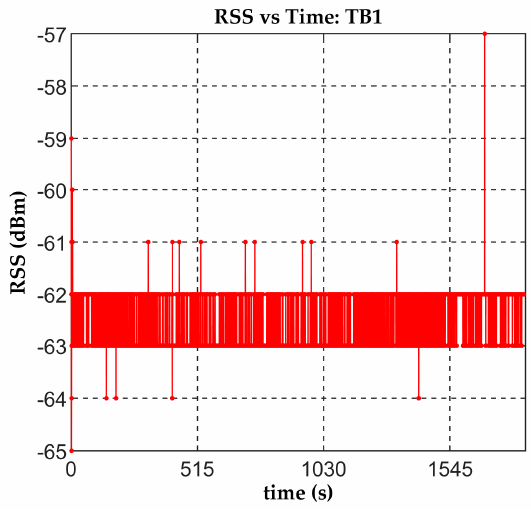
Figure 10. Evolution of RSS during one hour for TB1.